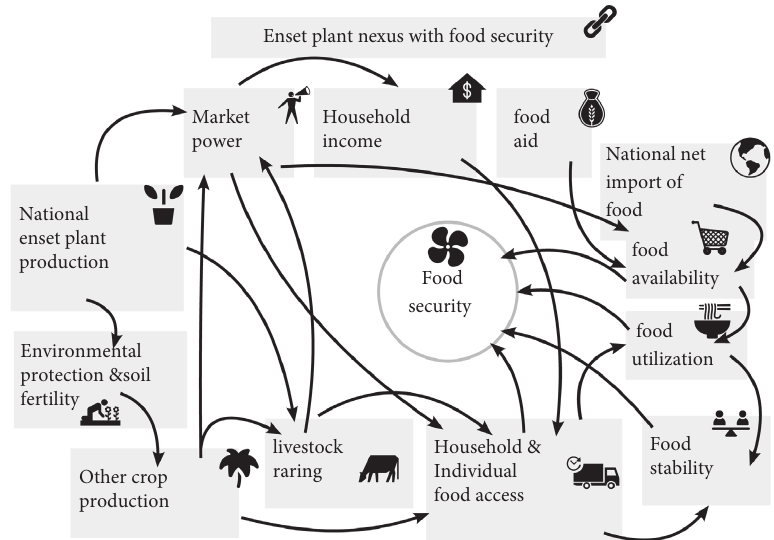
Figure 6: Enset crop link with food security. Source: authors own